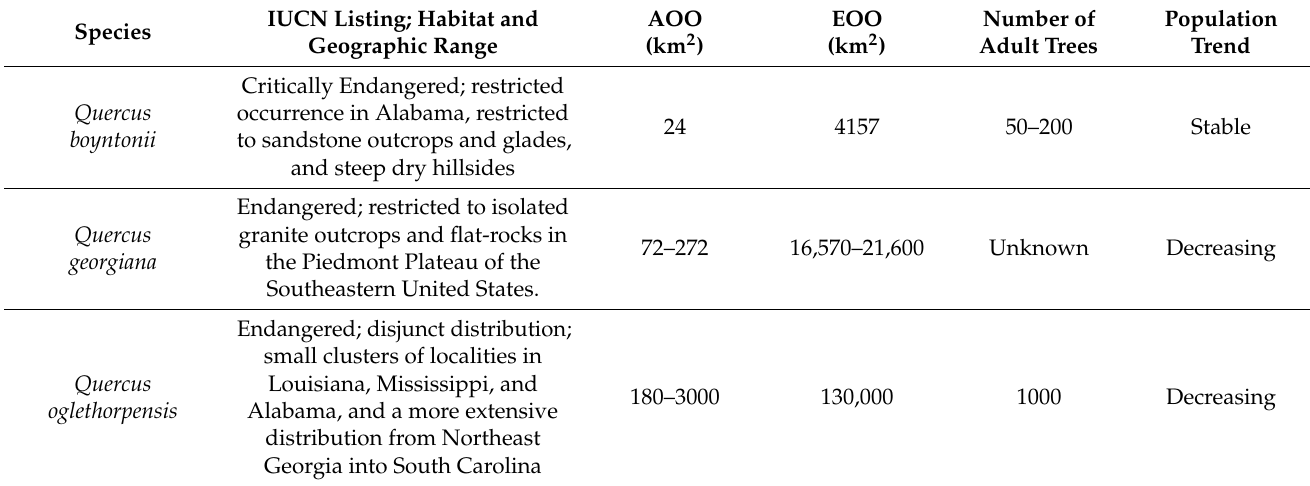
Table 1. Overview and comparison of each of the three species in this study showing geographic range, area of occupancy (AOO), extent of occurrence (EOO), number of adults estimated in the wild, and current population trends. Data compiled from IUCN Red List of Threatened